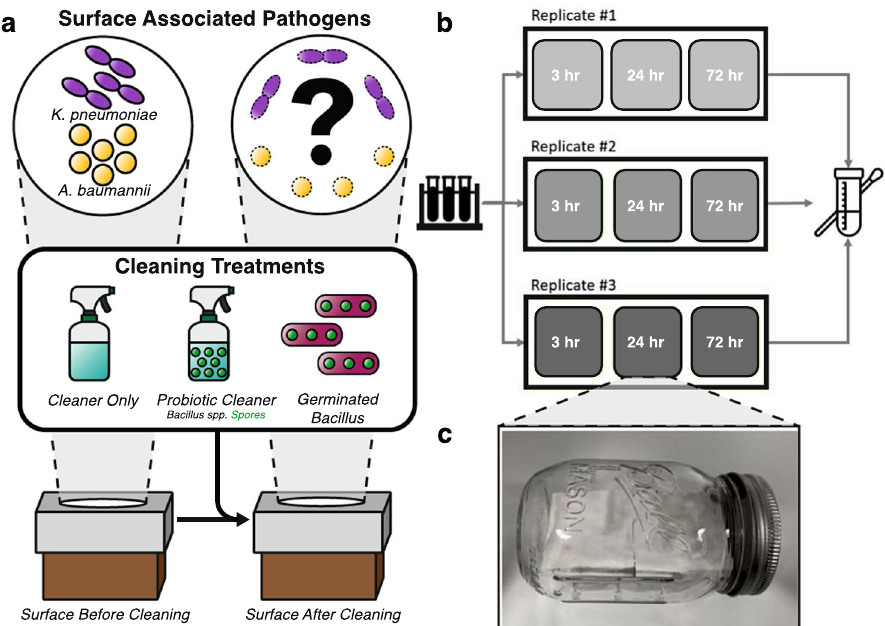
Fig. 1 Schematic describing the experimental design. General overview of the biological question ( a ). Microcosm experimental design ( b ) with four types of inocula containing pathogen ( A. baumannii or K. pneumoniae ) and Bacillus spp. and sealed sterile microcosm chamber maintained under ambient temperature and relative humidity ( c ). The elevated temperature and humidity condition was maintained by adding 10 mL of sterilized miliQ water into the sealed